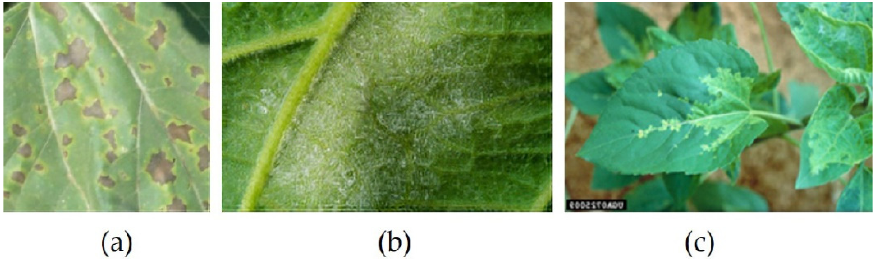
Figure 9. Images incorrectly classified by SVM. Image ( a ) shows the upper side. Image ( b ) shows the lower side. Image ( c ) shows the upper side.